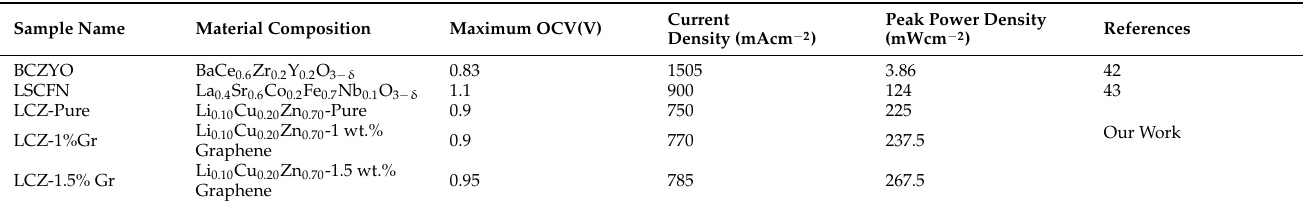
Table 2. Fuel cell performance observations at 600 ◦